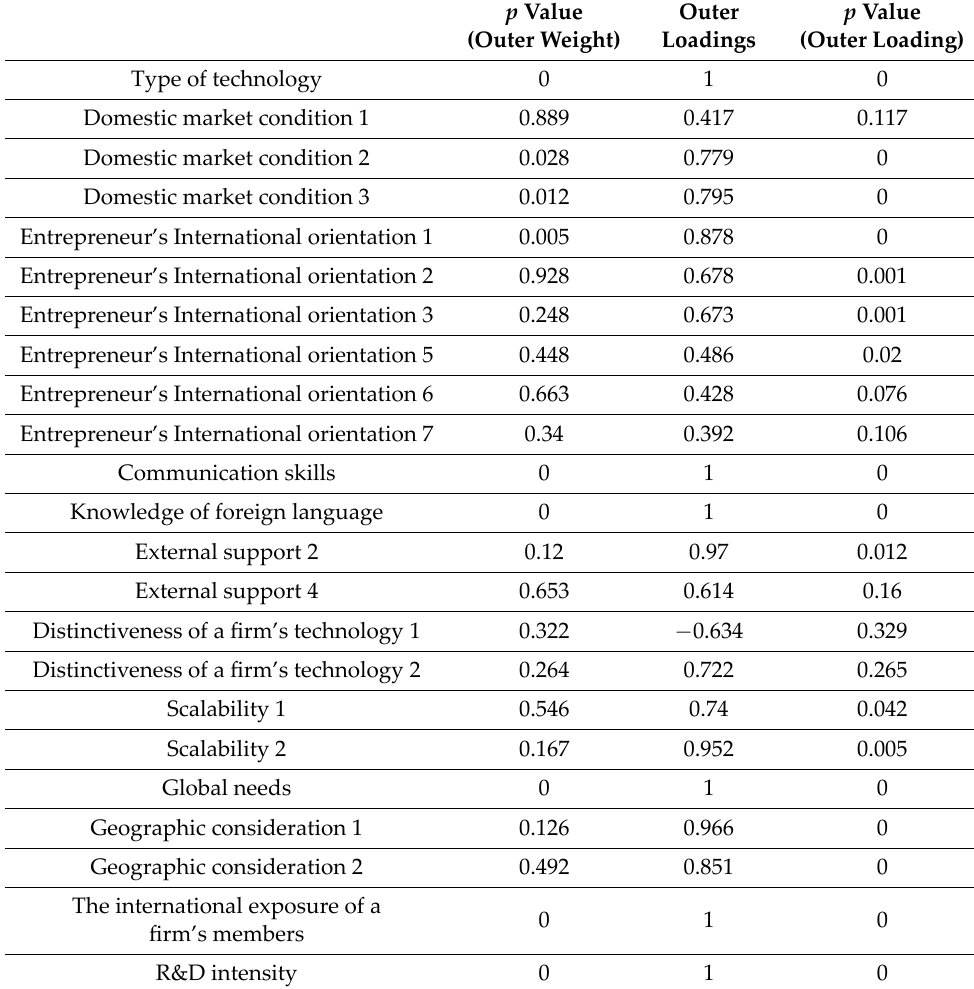
Table 2. Assess Measurement